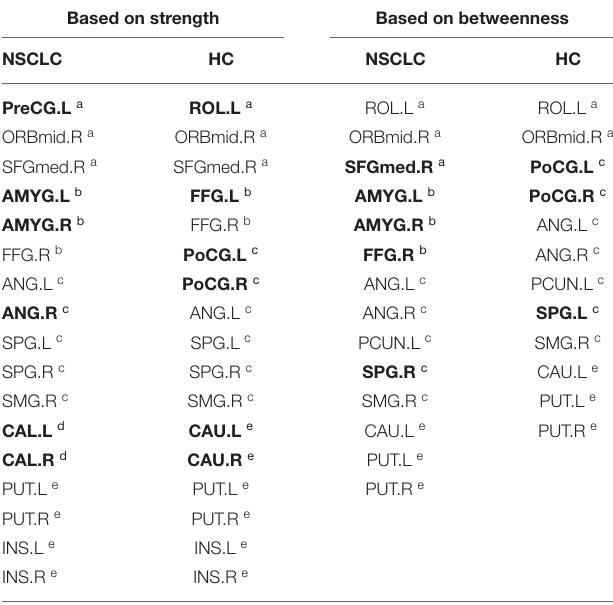
TABLE 3 | Hub regions based on nodal strength and betweenness between NSCLC and HC. Based on strength Based on betweenness